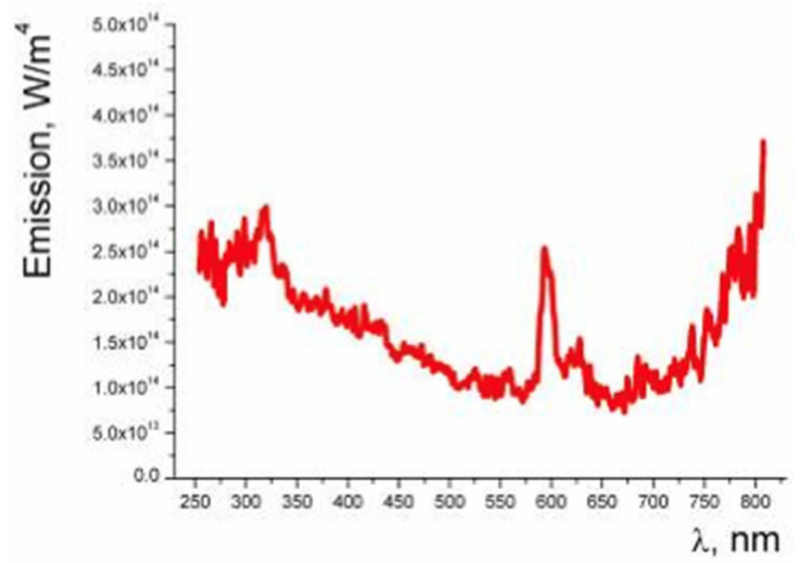
Figure 60. Tests performed in VUT-1: Emission spectrum obtained for 4050 m/s and 11.1 Torr